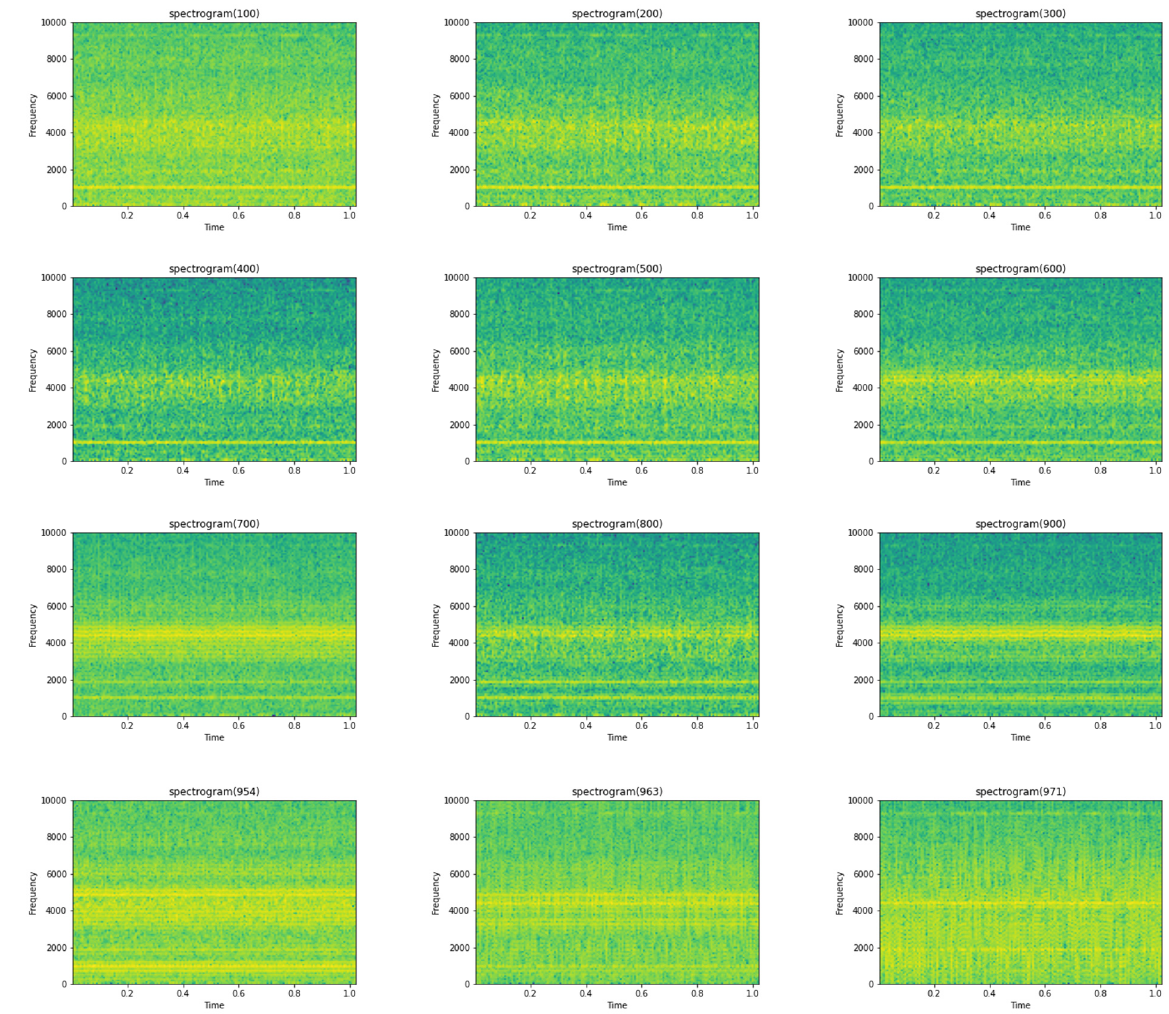
Figure 5. Sample spectrogram images at various timestamps.